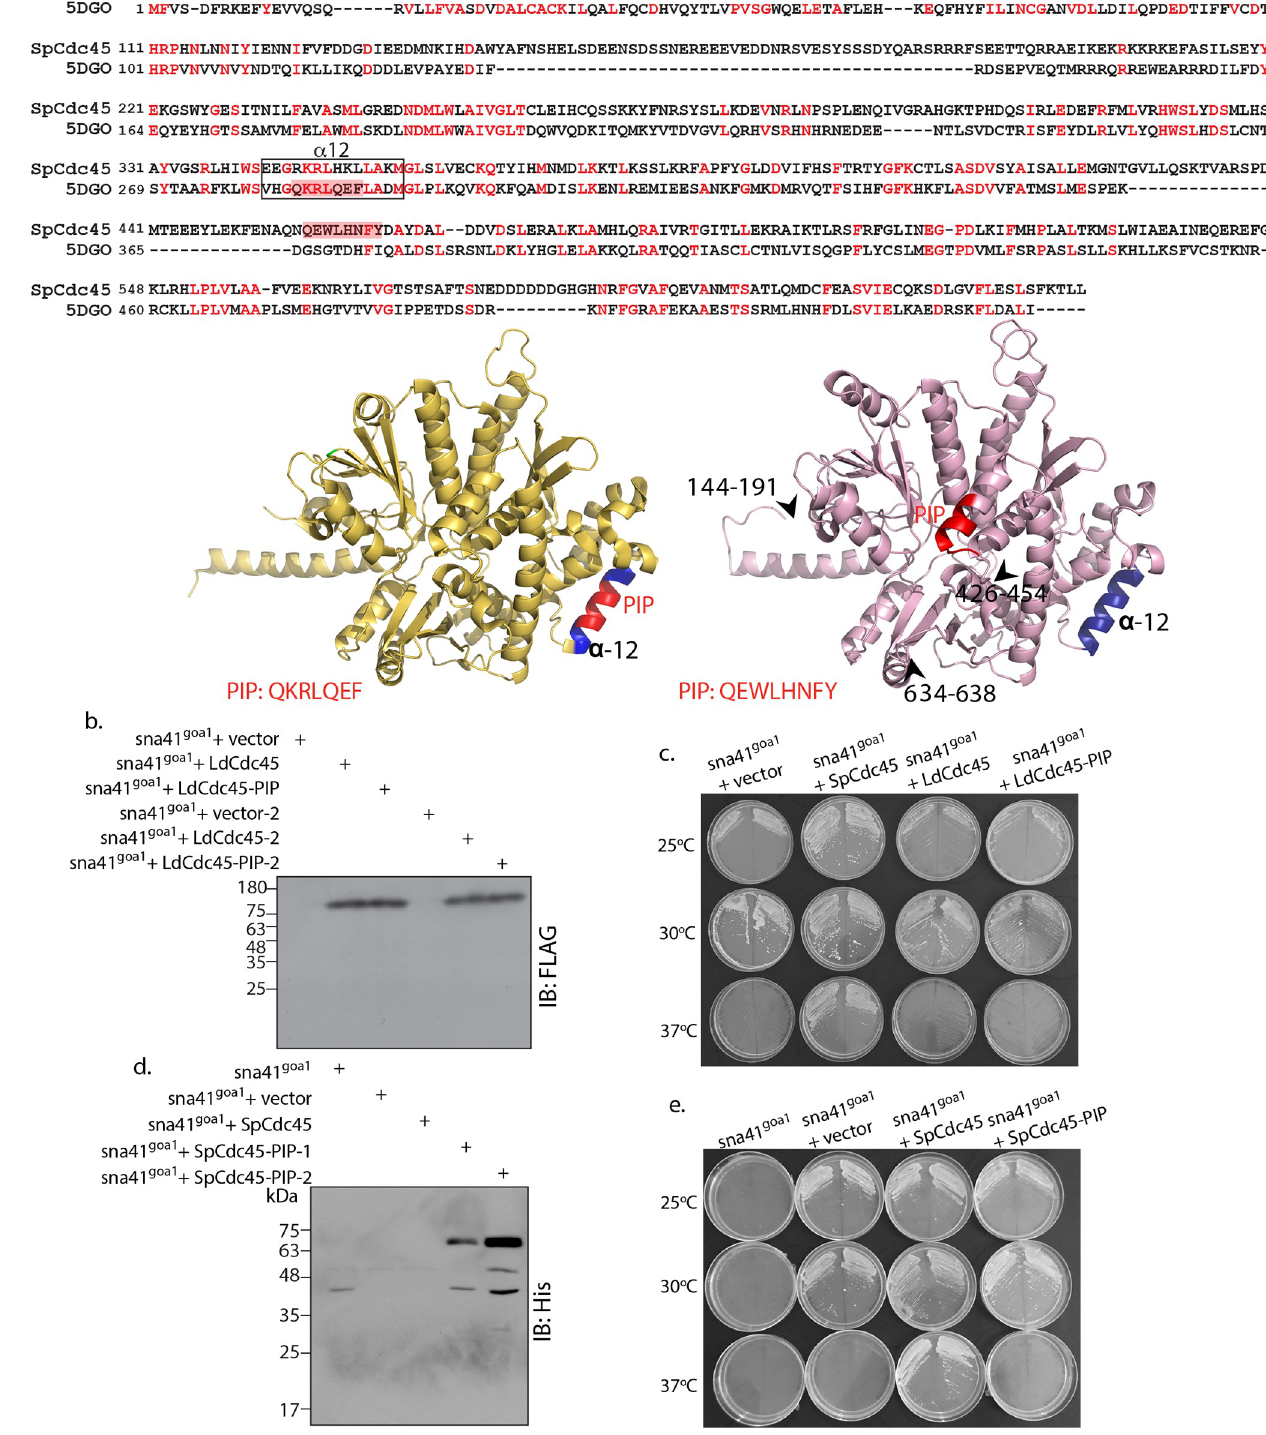
Fig 7. Cdc45-PIP box is essential for S . pombe cell survival. a. Upper panel: Sequence alignment of Schizosaccharomyces pombe Cdc45 against human Cdc45 generated by Phyre2. PIP boxes highlighted in red. Lower left panel: Human Cdc45 ribbon representation derived from crystal structure (PDB ID: 5DGO; [9]). Navy blue region indicates α 12 helix, red region depicts PIP box, sequence of PIP box indicated below structure. Lower right panel: Ribbon representation (pink) of 3D model of Schizosaccharomyces pombe Cdc45 modelled with Phyre2 using human Cdc45 (PDB ID: 5DGO) as template. Black arrowheads and associated numbers indicate amino acid stretches that have been excluded by Phyre2 during modeling. Navy blue region indicates α 12 helix. Red